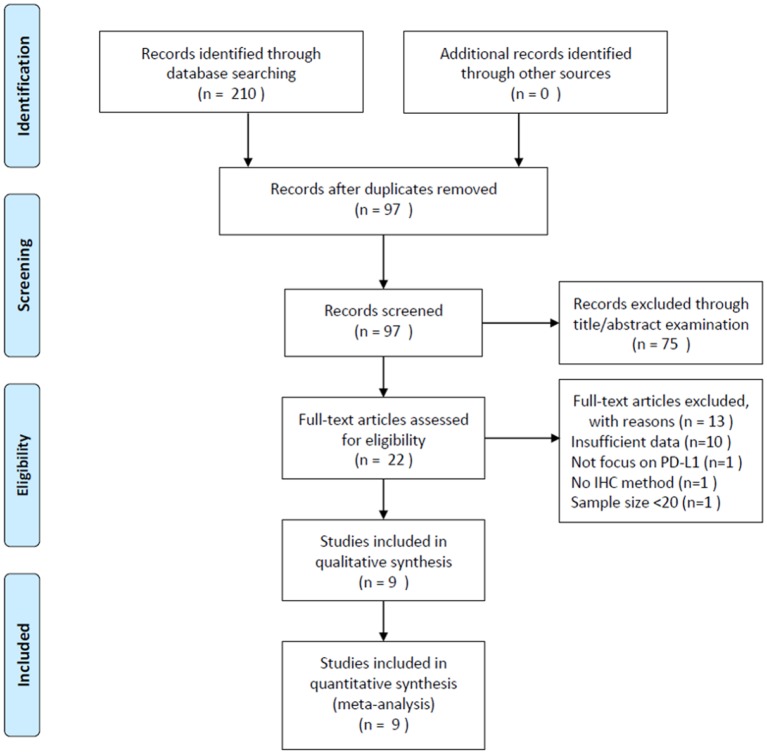
Literature review process.